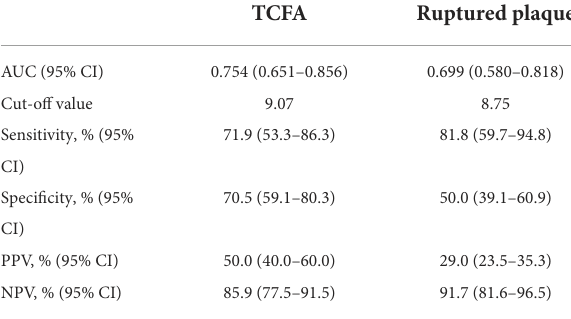
TABLE 5 Predictive performance of TyG index for non-culprit TCFA and ruptured plaque.